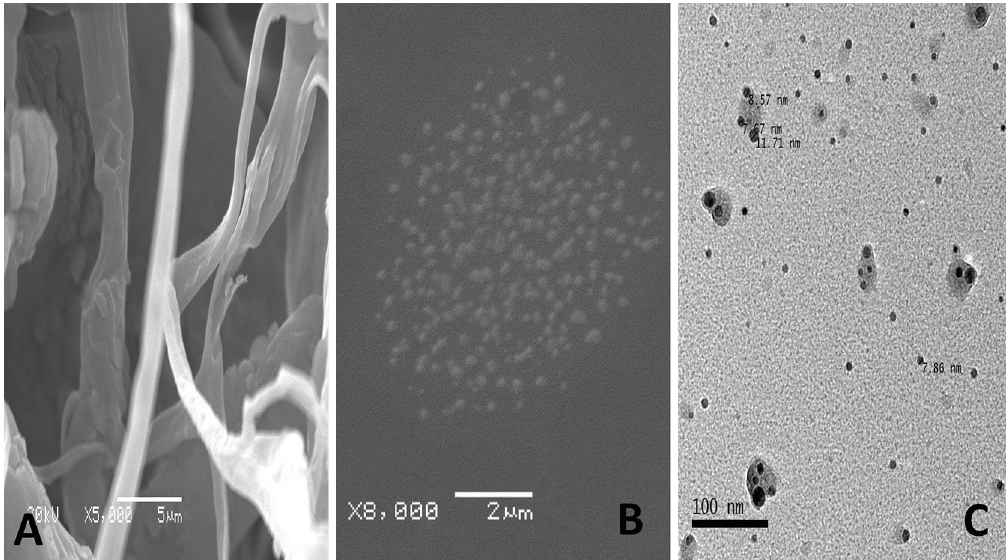
Figure 2. A scanning electron microscope (SEM) (5X) image showing Nile Tilapia fish scale-based collagen fibers ( A ), Nile Tilapia fish scale-based collagen nanoparticles showing smooth spherical shape by SEM (5X)